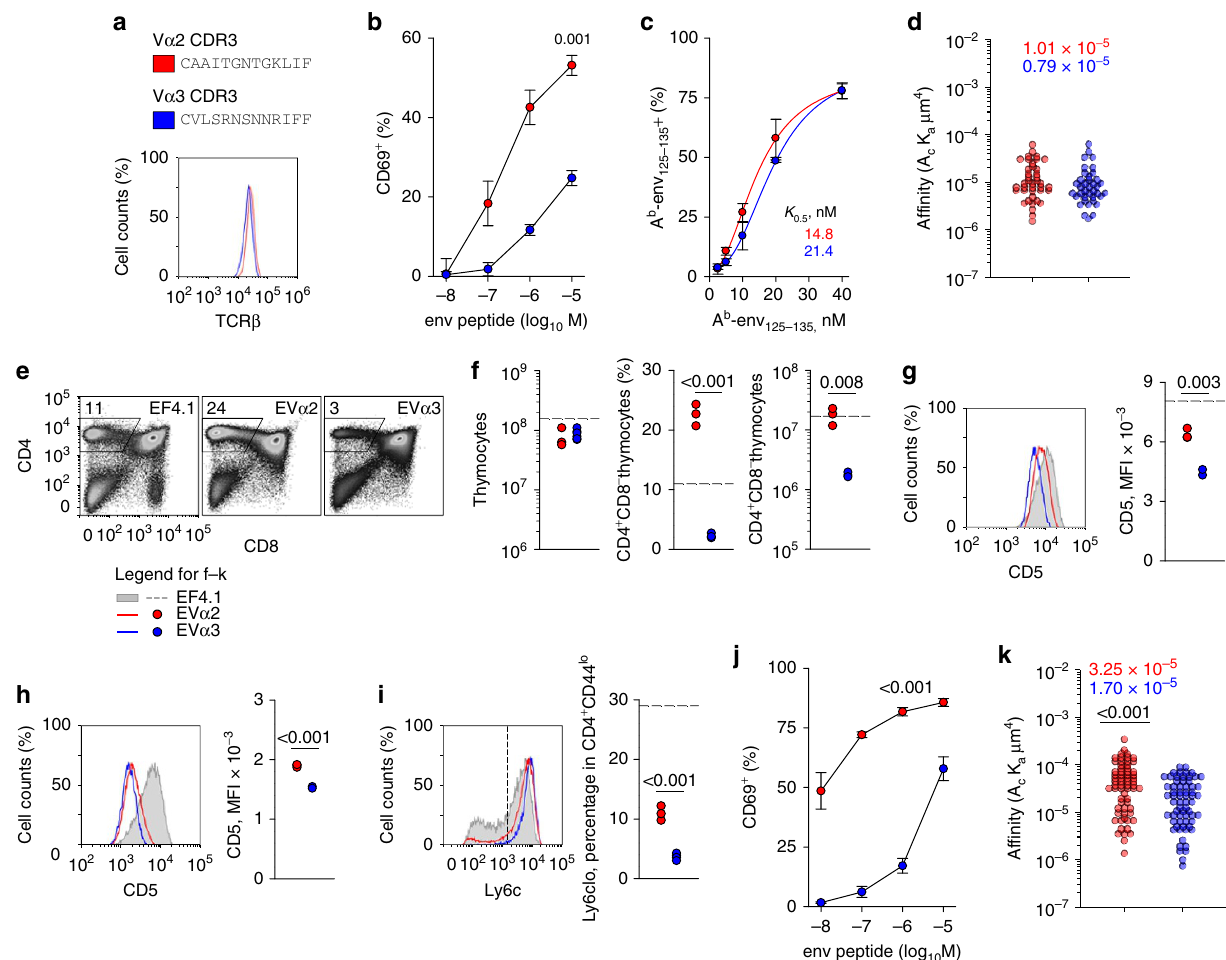
Figure 2 | Development and reactivity with self and foreign antigen of monoclonal EV a 2 and EV a 3 Tcells. ( a ) CDR3 sequences and TCR b expression levels in two hybridoma cells lines representing the indicated clonotypes. ( b ) Responsiveness of the same hybridoma cells lines as in a to overnight stimulation with env 122–141 peptide, measured by CD69 upregulation ( n ¼ 2). ( c ) Frequency of A b -env 125–135 tetramer-positive cells, at different tetramer concentration, following staining of the same hybridoma cells lines as in a and normalized for TCR expression. Symbols represent the means ( ± s.e.m., n ¼ 2) of experimental data, whereas lines are fits using a four-parameter Hill equation. Numbers next to the regression lines denote apparent affinity ( K 0.5 ) estimates. ( d ) Effective two-dimensional TCR affinities for A b -env 125–135 of T-cell hybridomas measured by the micropipette adhesion frequency assay and normalized by TCR surface density. Each individual data point represents the affinity of a single T cell. Numbers in the plot represent the effective affinity geometric mean of the population. ( e ) Flow cytometric analysis of thymocyte development in EF4.1, EV a 2 and EV a 3 TCR-transgenic mice. ( f ) Absolute number of total thymocytes and frequency and number of CD4 single-positive thymocytes in the same mice as in e . ( g ) CD5 levels in post-selection (CD4 þ CD8 (cid:2) TCR high ) thymocytes from the same mice as in e . ( h ) CD5 levels in naive splenic CD4 þ Tcells from EV a 2 and EV a 3 mice. ( i ) Ly6c levels in naive splenic CD4 þ T cells from the same mice. In f – i , each symbol represents an individual mouse from one representative of two experiments. Horizontal dashed lines represent the mean values for control EF4.1 mice. ( j ) Responsiveness of EV a 2 and EV a 3 T cells to overnight env 124–138 peptide stimulation. Responses were measured by CD69 upregulation and are plotted as means ( ± s.e.m., n ¼ 3–4). ( k ) Effective two-dimensional TCR affinities for A b -env 125–135 of primary T cells measured by the micropipette adhesion frequency assay and normalized by TCR surface density, and plotted as described in d